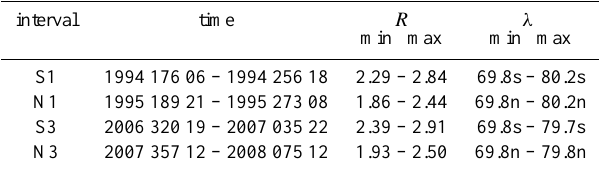
Table 2. Data intervals used for the multi-scale analysis of velocity differences: start and end times (year, day, hour), minimum and maximum distances ( R , in AU), and latitudes ( λ , in degrees, with n and s for North and South,